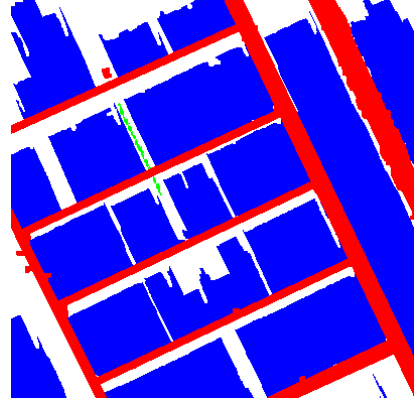
Figure 10. Final map produced from proposed